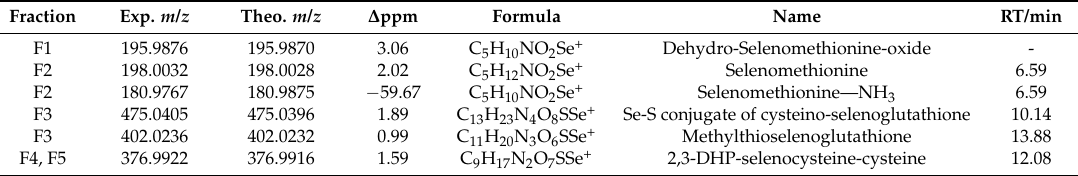
Table 1. Selenium compounds identified in yeast extract using the UHPLC-(ESI)-Orbitrap-MS technique. Fraction Exp. m / z Theo. m / z ∆ ppm Formula Name